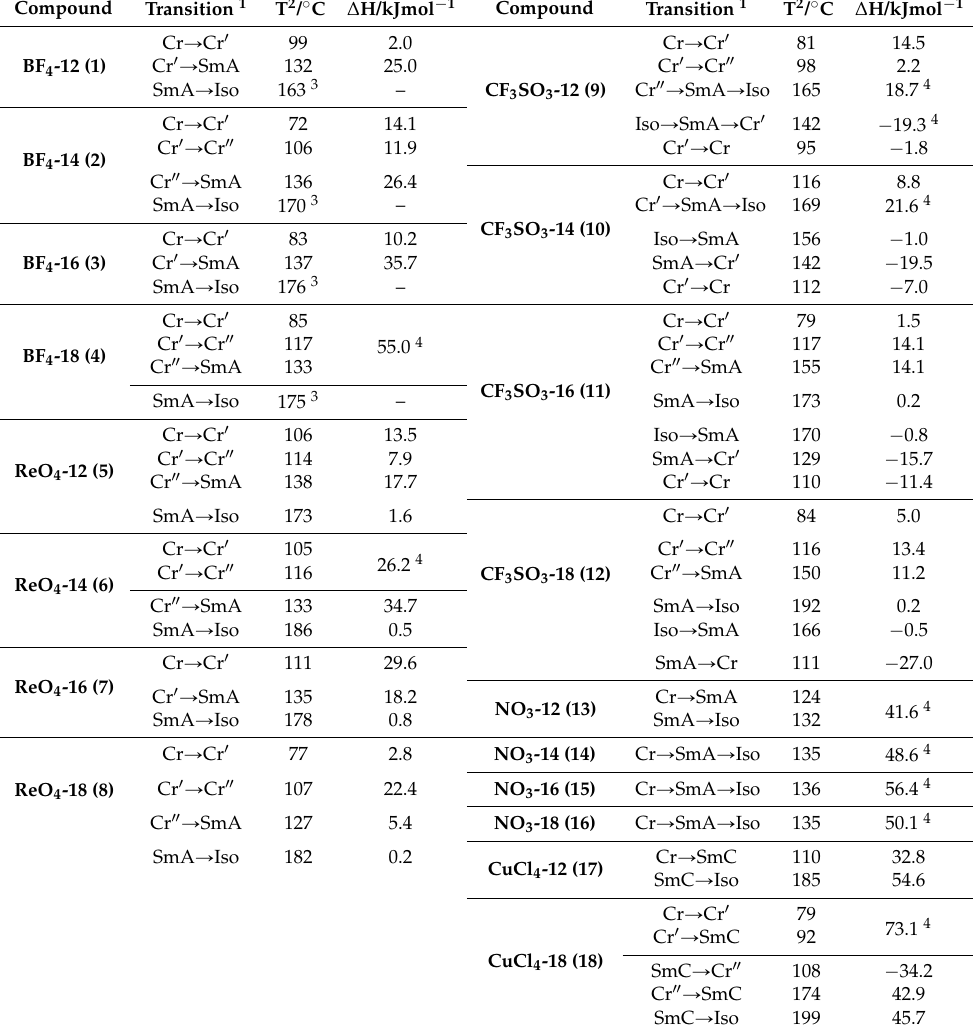
Table 2. Thermal data of compounds of the families I (BF 4 -n), II (ReO 4 -n), III (CF 3 SO 3 -n), IV (NO 3 -n) and V (CuCl 4